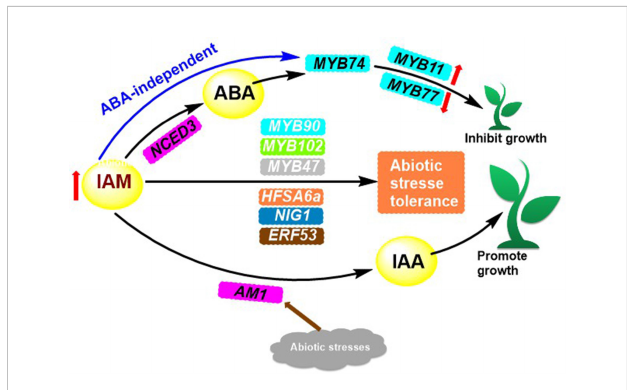
FIGURE 4 Melatonin regulates IAA biosynthesis and transport as well as regulates abiotic stress responses in